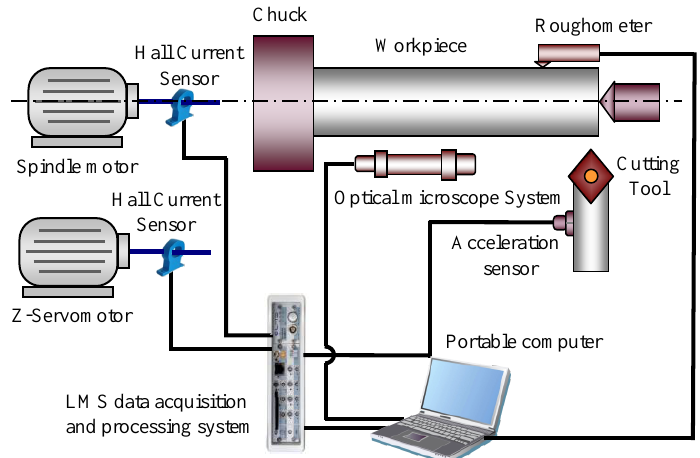
Figure 2. The schematic diagram of the experimental